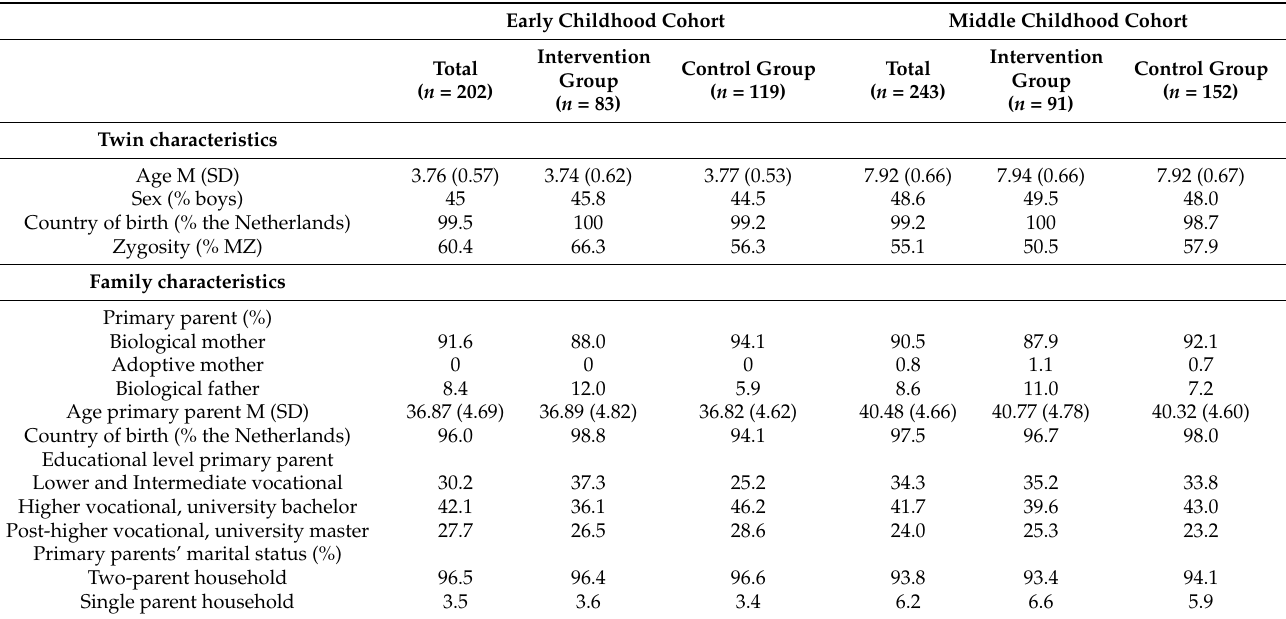
Table 1. Characteristics of the complete sample, and separately for the intervention and control